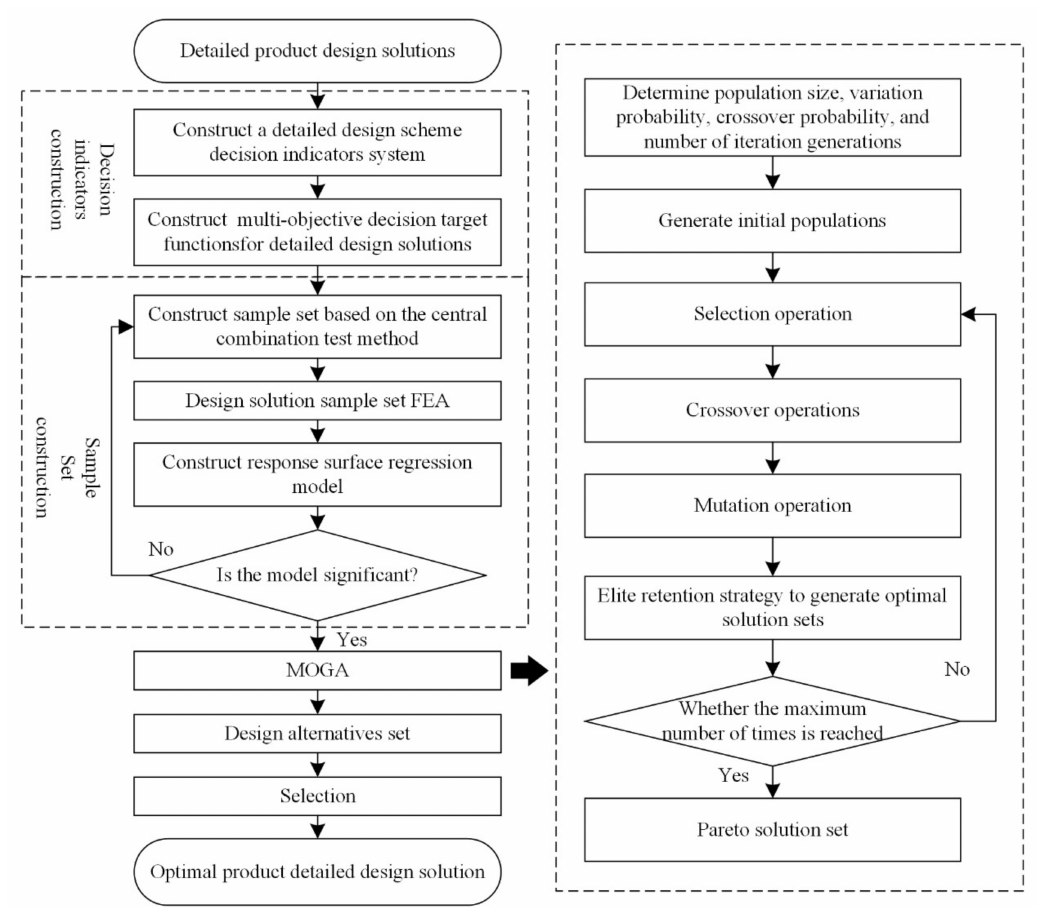
Figure 4. MOGA-based product detail design solution decision flow